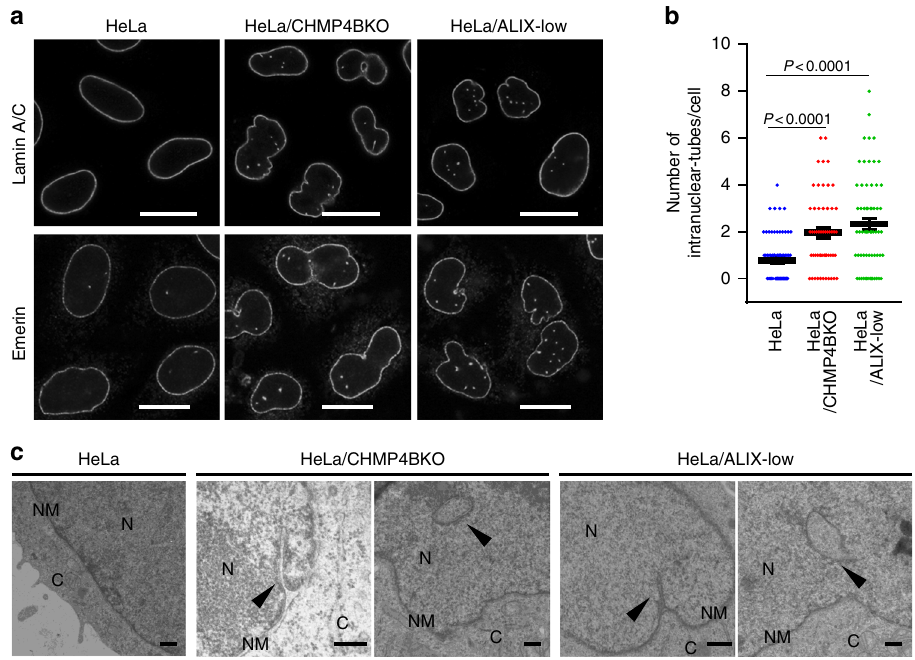
Fig. 9 ESCRT-III contributes to maintenance of the integrity of the inner nuclear membrane in normal HeLa cells. a Confocal microscope images of HeLa, HeLa/CHMP4B KO, and HeLa/ALIX-low cells stained with Lamin A/C (top row) or Emerin (bottom row). Bars, 20 μ m. Images are representative of 3 independent experiments. b The number of trans-nuclear tubes in the experiments in ( a ) was measured ( n = 74 for HeLa, n = 55 or HeLa/CHMP4B KO, n = 63 for HeLa/ALIX-low). Data are shown as the mean ± SEM and are representative of three independent experiments. The indicated P -values were obtained using the Tukey ’ s test. c Electron microscope images of the cells in ( a ). Arrowheads indicate trans-nuclear tubes derived from the INM. C cytoplasm, N nucleus, NM nuclear membrane. Bars, 500 nm. Images are representative of three independent